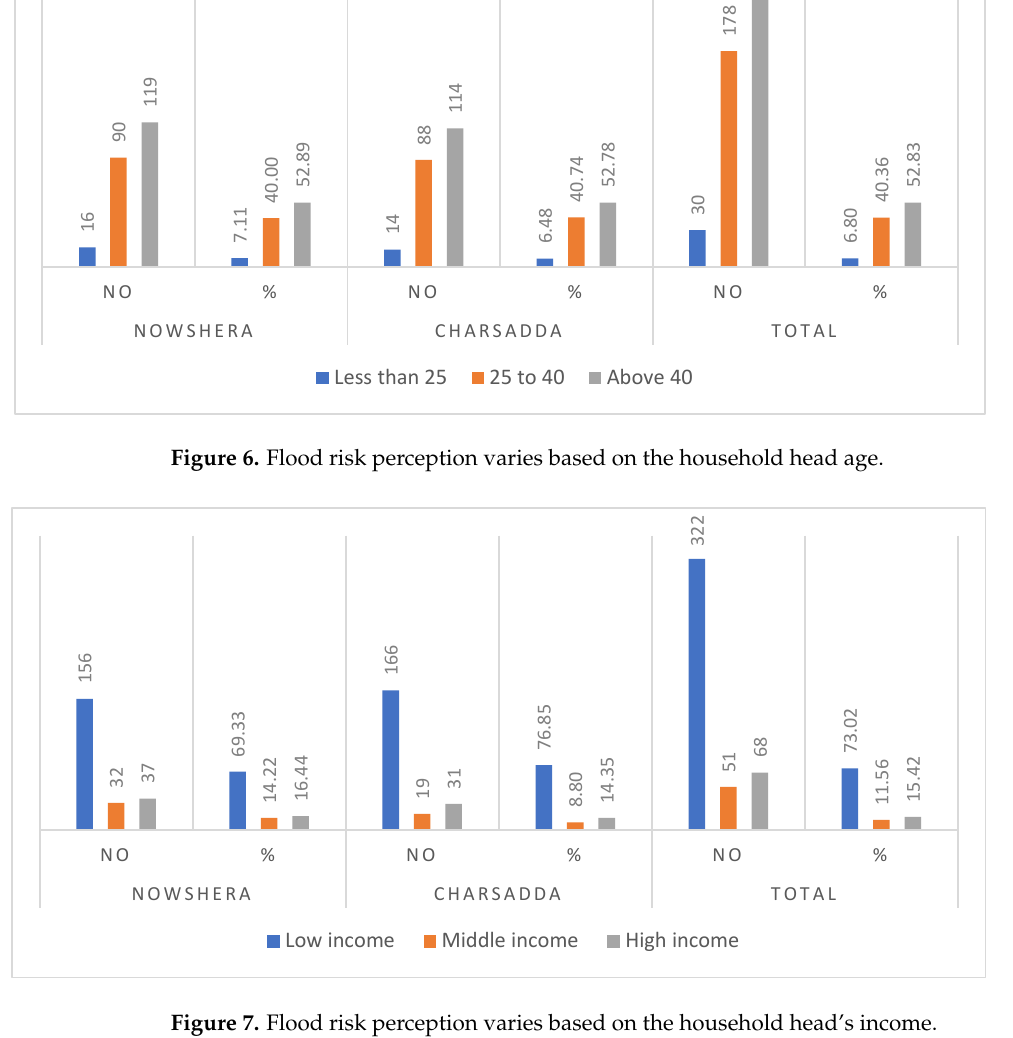
Figure 7. Flood risk perception varies based on the household head ’s income.